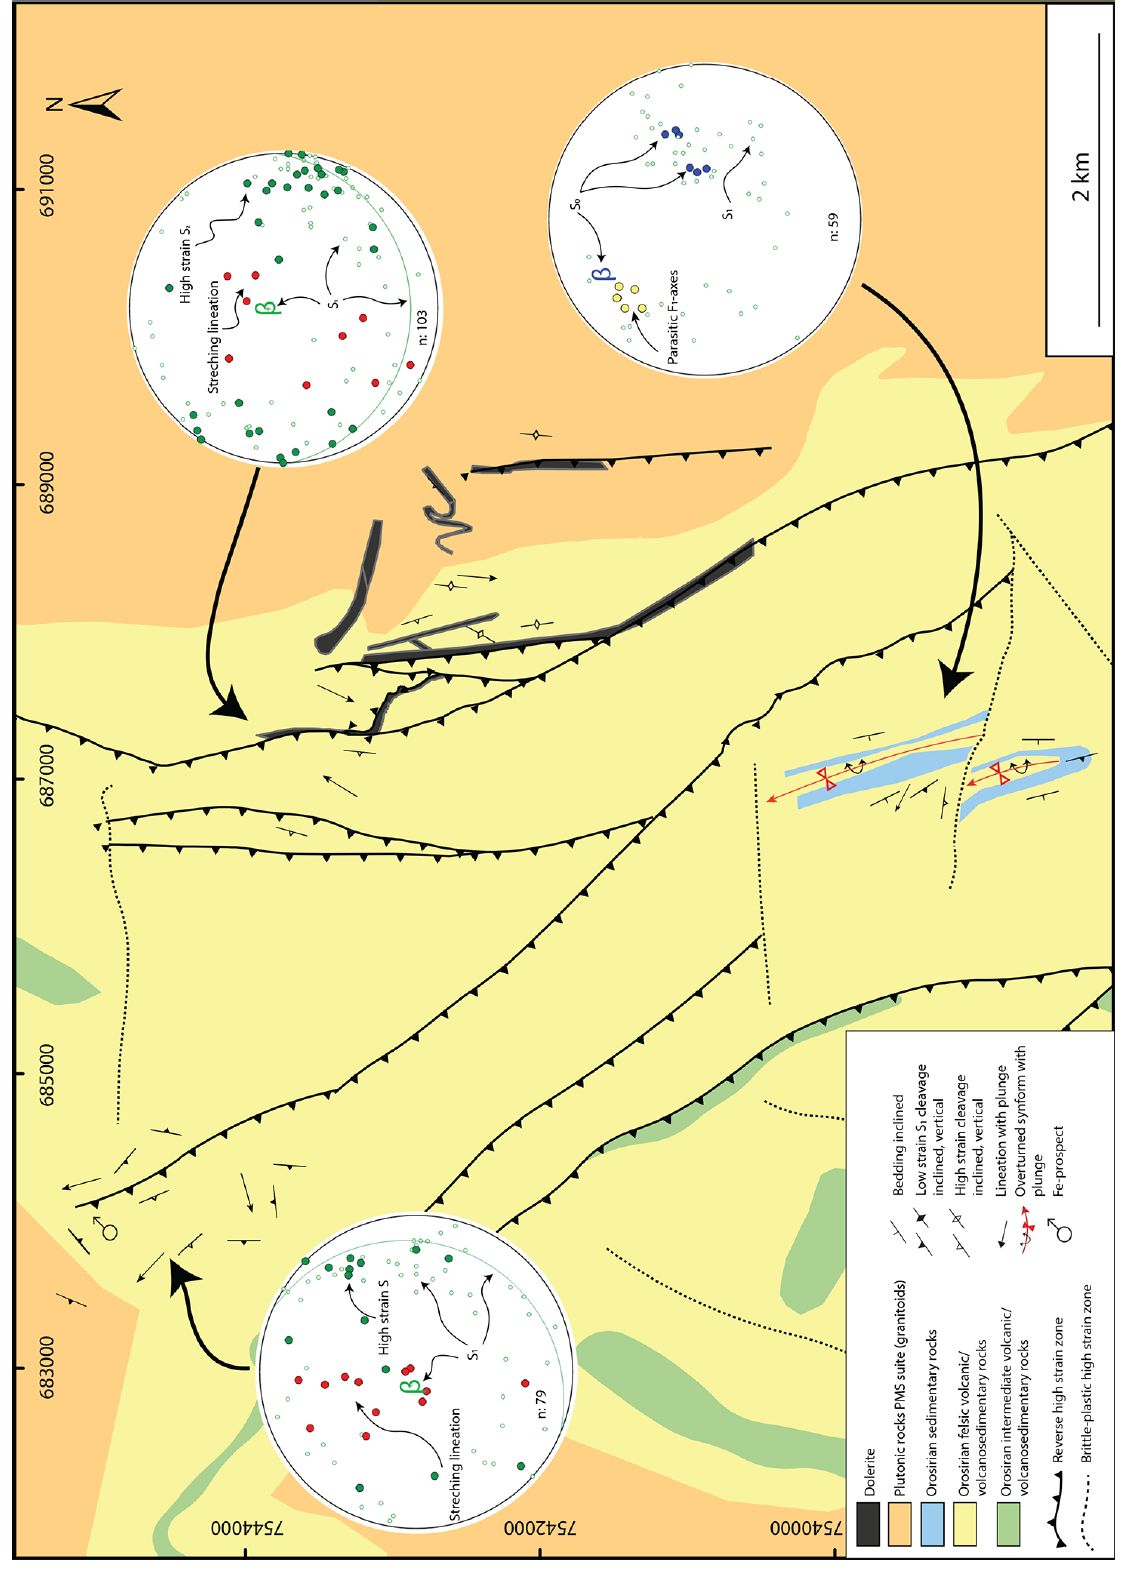
Figure 5. Geological map of the Eustiljåkk key area. Modified after Offerberg (1967). Coordinates: